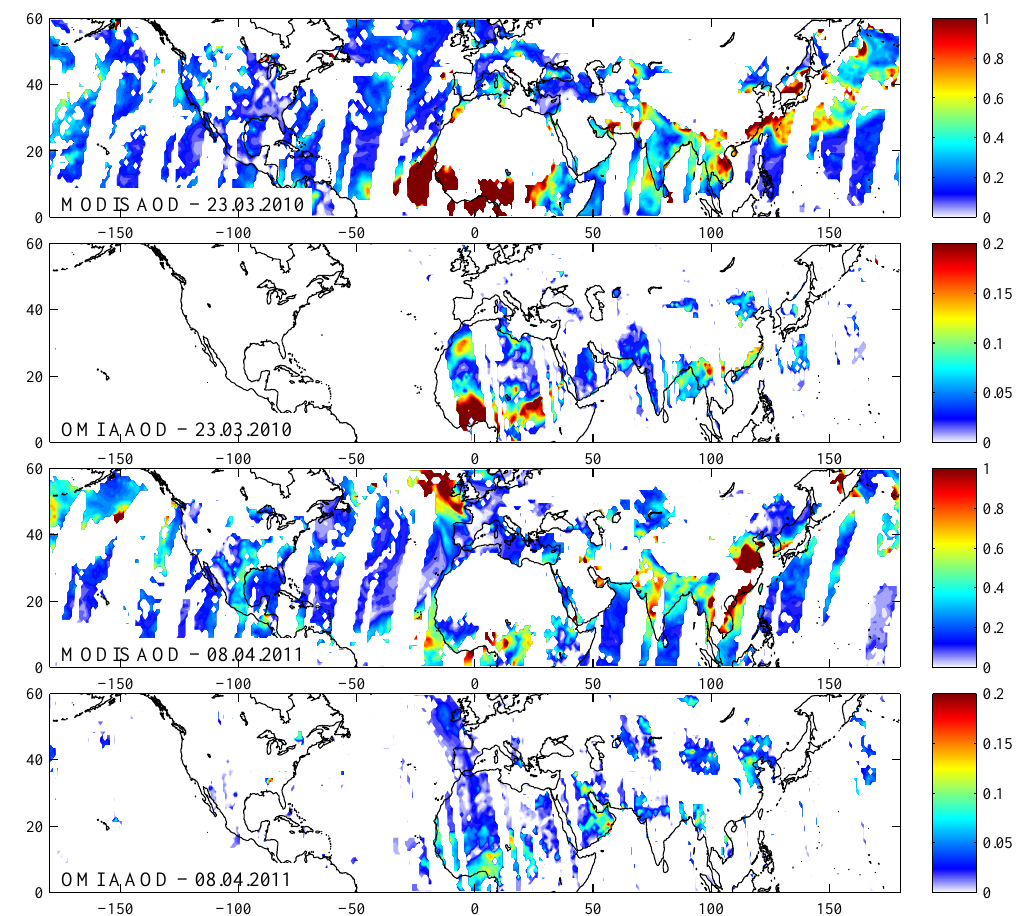
Fig. 6. MODIS (Terra) aerosol optical depth measurements at 550 nm and OMI absorption aerosol optical depth measurements at 500 nm on 23 March 2010 (top) and 8 April 2011 (bottom). Data downloaded from the Giovanni online data system (http://disc.sci.gsfc.nasa.gov/ giovanni/overview).